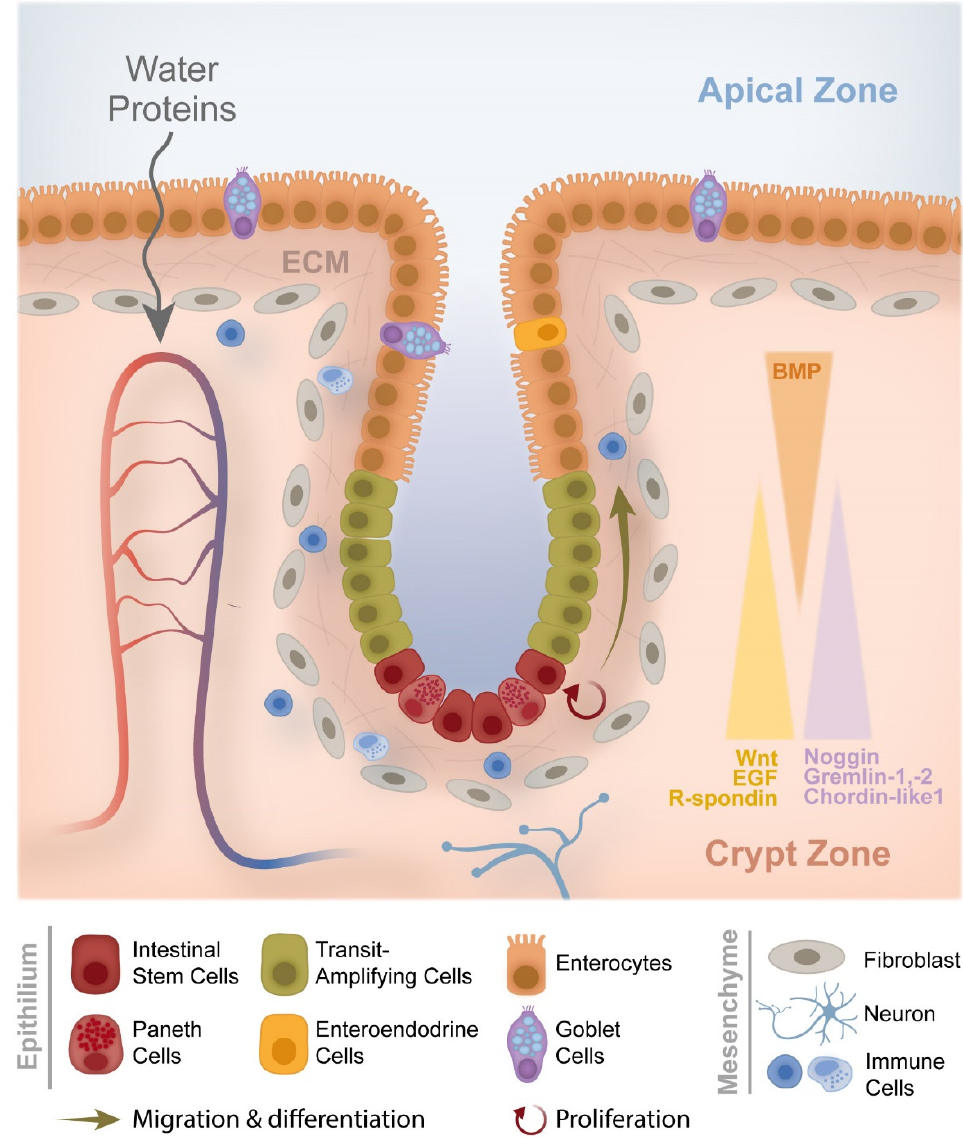
Figure 2. The intestinal stem cells are at the bottom of the crypt. These cells give rise to transit amplifying cells. During their differentiation, these cells migrate along the crypt, reaching the surface. Intestine stem cells regulation, as well as the proliferation and differentiation processes, are mediated by signals which come from the surrounding mesenchymal cells. At the bottom of the crypt, are expressed genes (Wnt, R-spondin, EGF) that regulate the cell cycle, and the intestine stem cells and progenitors increase, despite the genes inducing apoptosis being downregulated. The bone morphogenetic protein (BMP) pathways are expressed on the top of the crypt. In the meantime, BMP antagonists (noggin, gremlin, and chordin-like 1) are expressed, at the bottom of the crypt, by stromal cells. R-spondin is a protein that promotes the canonical Wnt/ β -catenin pathway signaling. Adapted from Audrey [6,15,26]. ECM—extracellular matrix; EGF—Epidermal growth factor; Wnt—Wingless and